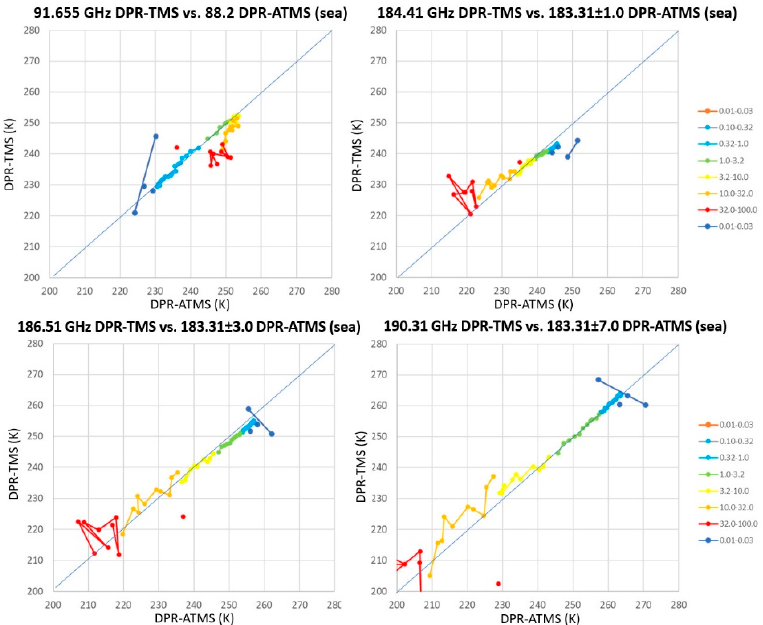
Figure 3. Plots of Tb–rainrate relationships between the DPR–ATMS and the DPR–TMS with the colors representing the rainrate categories. Only ocean areas are shown due to the number of observations available from the TMS: a total of 1.6 M colocated DPR–TMS observations vs. 18 M DPR–ATMS observations were used.